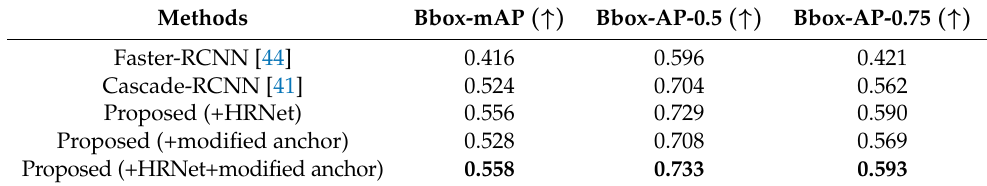
Table 1. Comparison of 2D detection results on three metrics: Mean AP (mAP), AP with a threshold of 0.5 and 0.7, respectively (AP-0.5, AP-0.7). The best values are displayed in